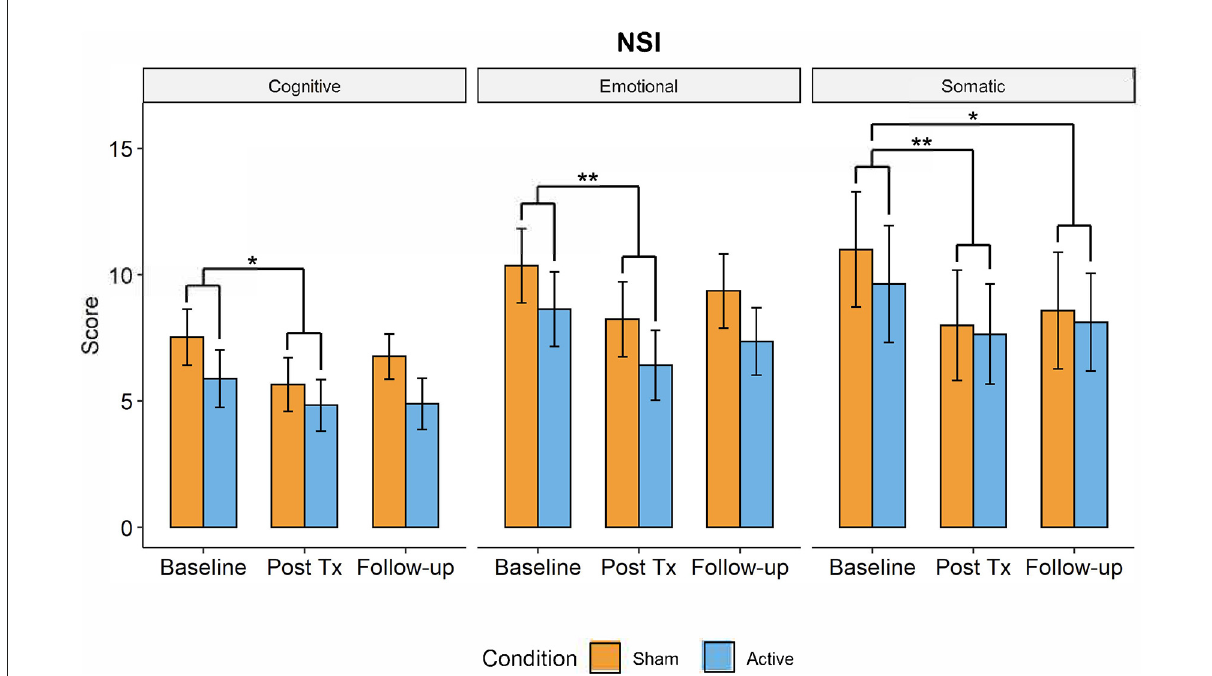
FIGURE5 Changes in post-TBI symptom severity measured by the Neurobehavioral Symptom Inventory over time (active in blue, control group in orange) from baseline to post-treatment to 1-month followup visits. Somatic, cognitive, and emotional symptoms significantly decreased from baseline to post-treatment visit but had increased by 1-month follow-up. There were no significant differences in symptom severity between active and control groups (* p < 0.05, ** p <